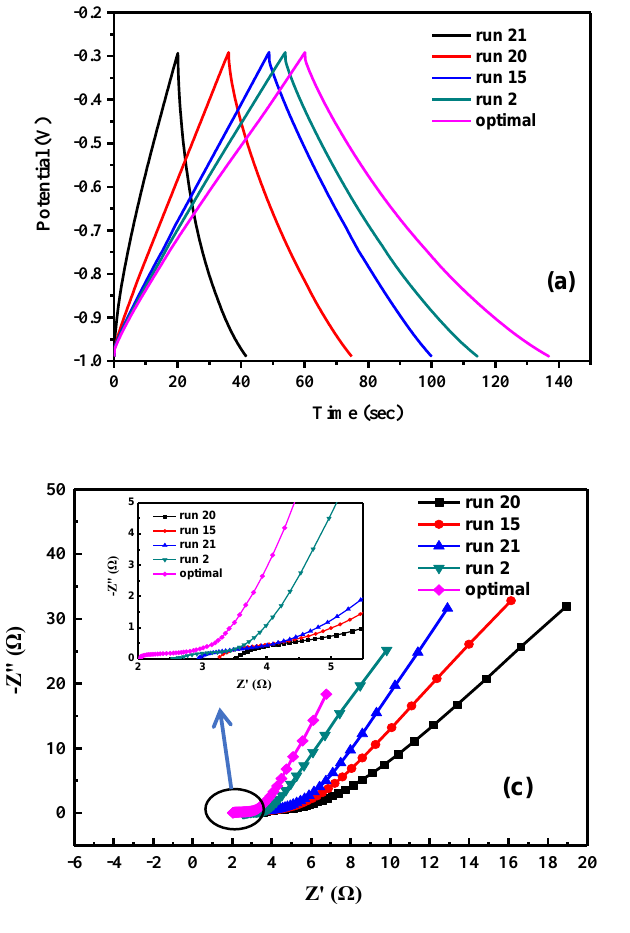
Figure 8. The electrochemical properties of activated carbon electrodes of samples. ( a ) The charge– discharge behavior of activated carbon electrodes, ( b ) the GCD test of the optimal sample at different current densities. of samples the specific capacitance, ( c ) the impedance analysis of different samples of activated carbon.